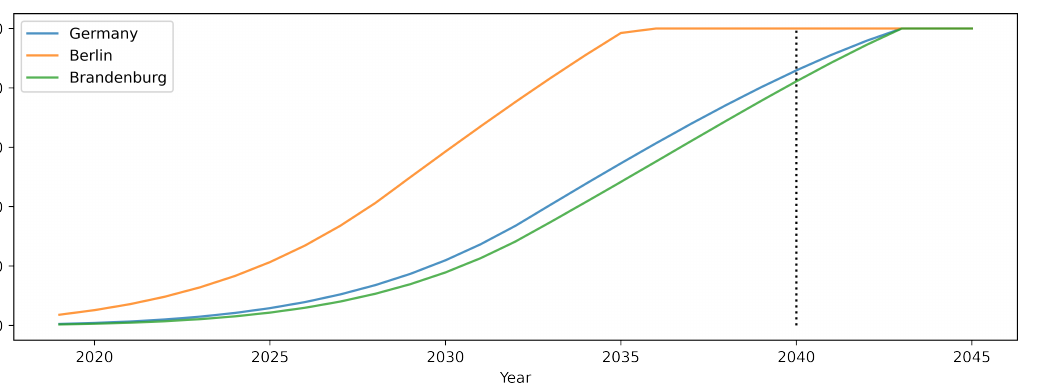
Figure 1. Ramp-up of electromobility in Germany, Berlin and Brandenburg Assuming a constant level of motorisation (number of cars per inhabitant), in 2040, around 1.12 million cars will be registered in Berlin and 1.38 million cars in Brandenburg. Different development rates are applied to determine the number of electric passenger cars following the different electrification development in the urban and the rural federal state. By 2040, in Berlin, all registered passenger cars are expected to be electric, while in Brandenburg, this share amounts to around 82%.